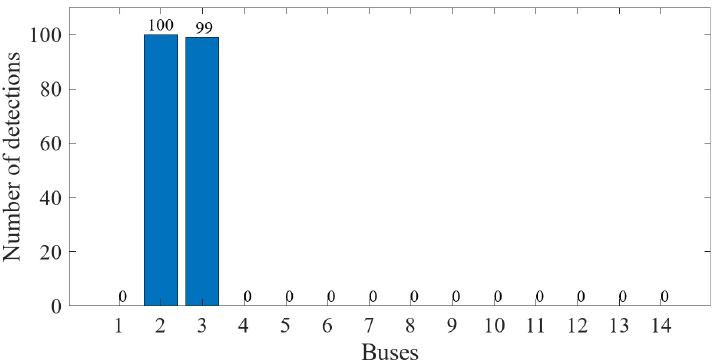
Figure 23. Detection results of false